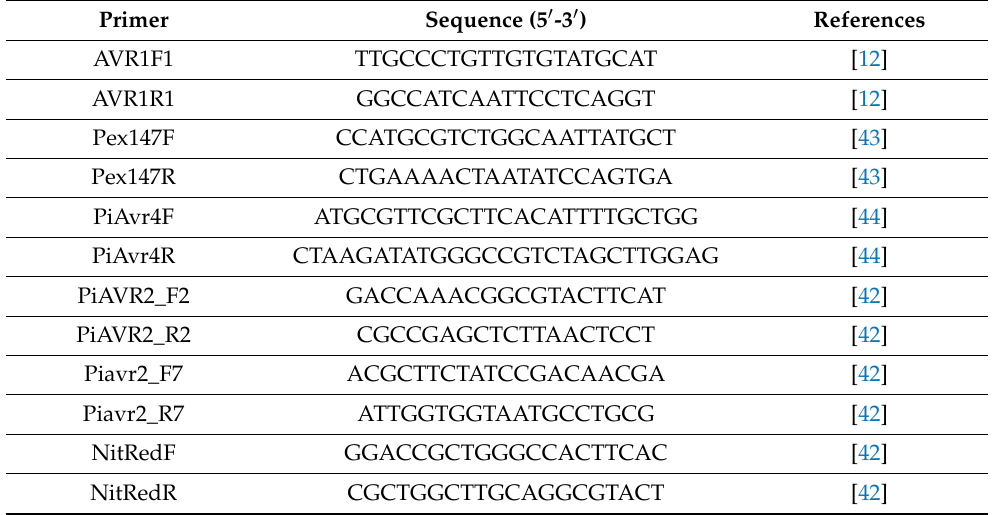
Table 1. Primers used to detect the presence and absence of effector genes in P. infestans isolates. Primer Sequence (5 (cid:48) -3 (cid:48)